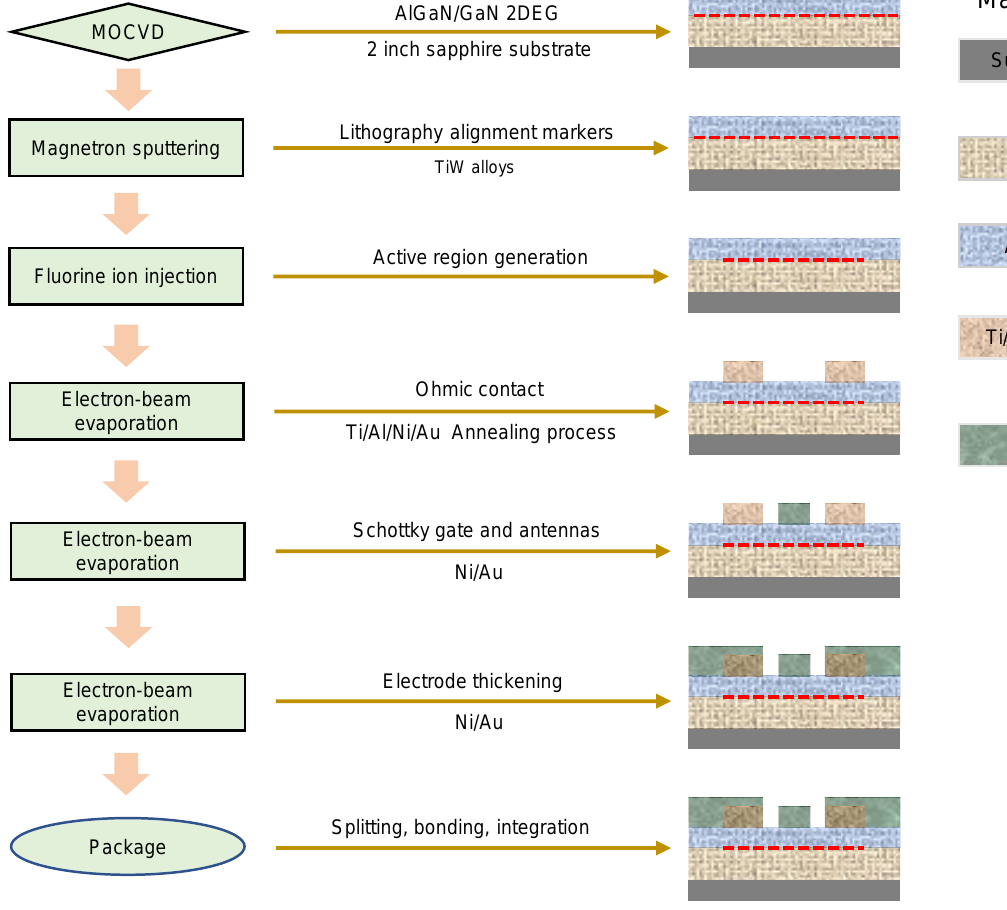
Figure 4. Schematic of the complete fabrication process of the THz HEMT